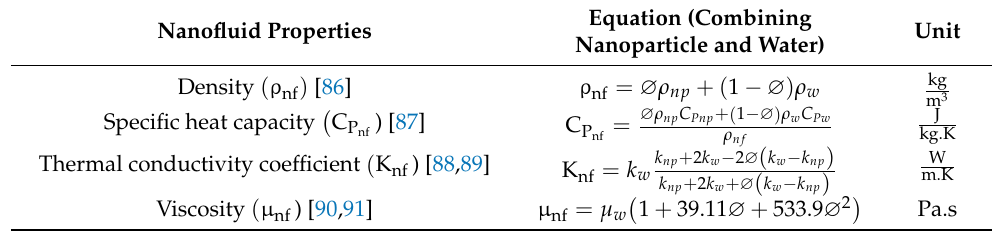
Table 7. Properties of nanofluids.